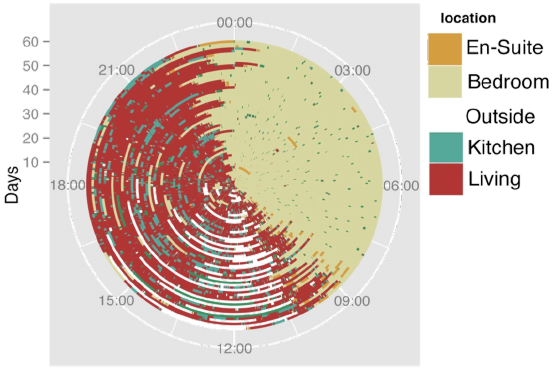
Fig 2. Clock plot displaying GNH resident home activity over a 60-day